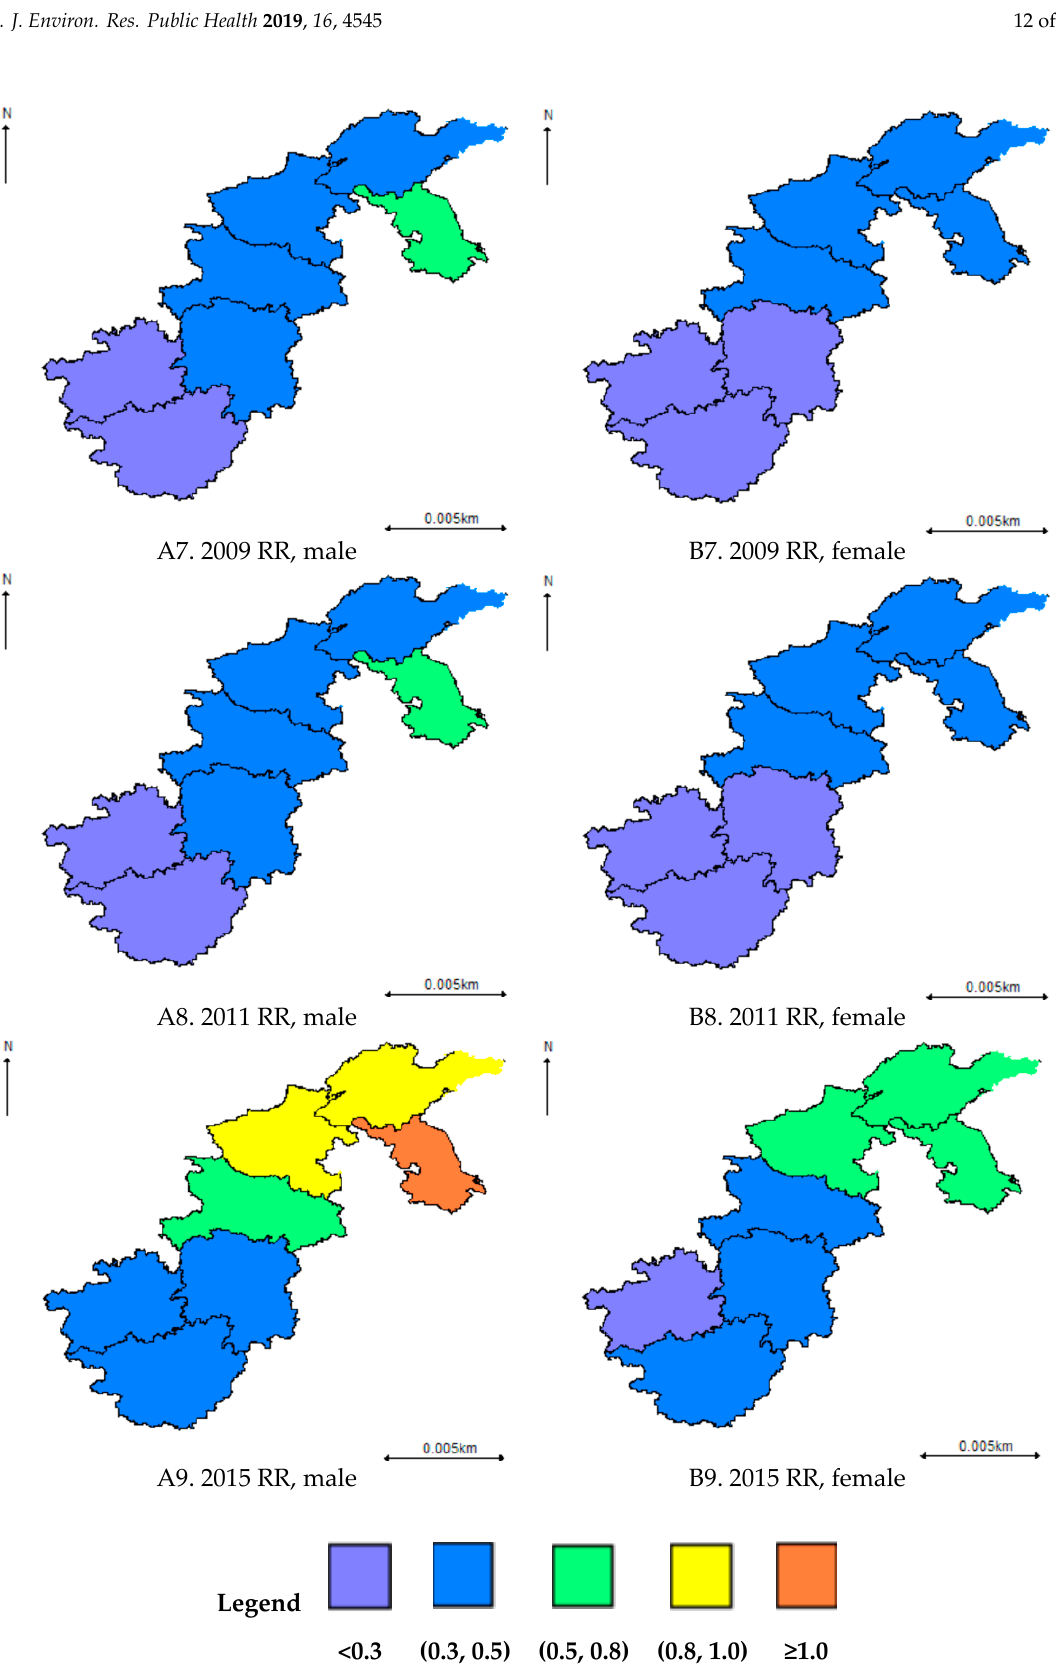
Figure 5. Posterior means of hypertension risk derived from the spatio-temporal Besag, York, and Mollie (BYM) model.